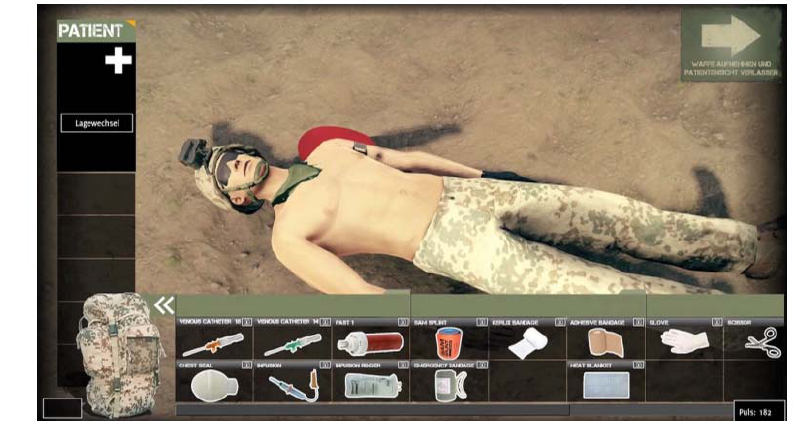
Figure 8 – Screen-shot of the SanTrain game (Dobrovsky et al, 2017) Рис . 8 – Изображение из игры SanTrain (Dobrovsky et al, 2017)